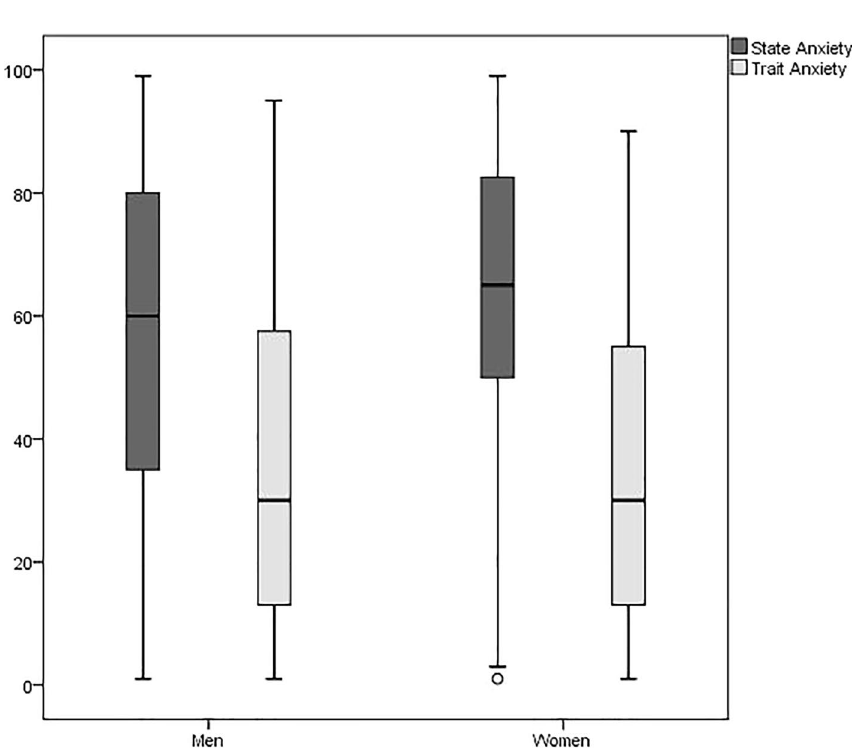
Figure 2. Comparison of median preoperative SA and TA between men and